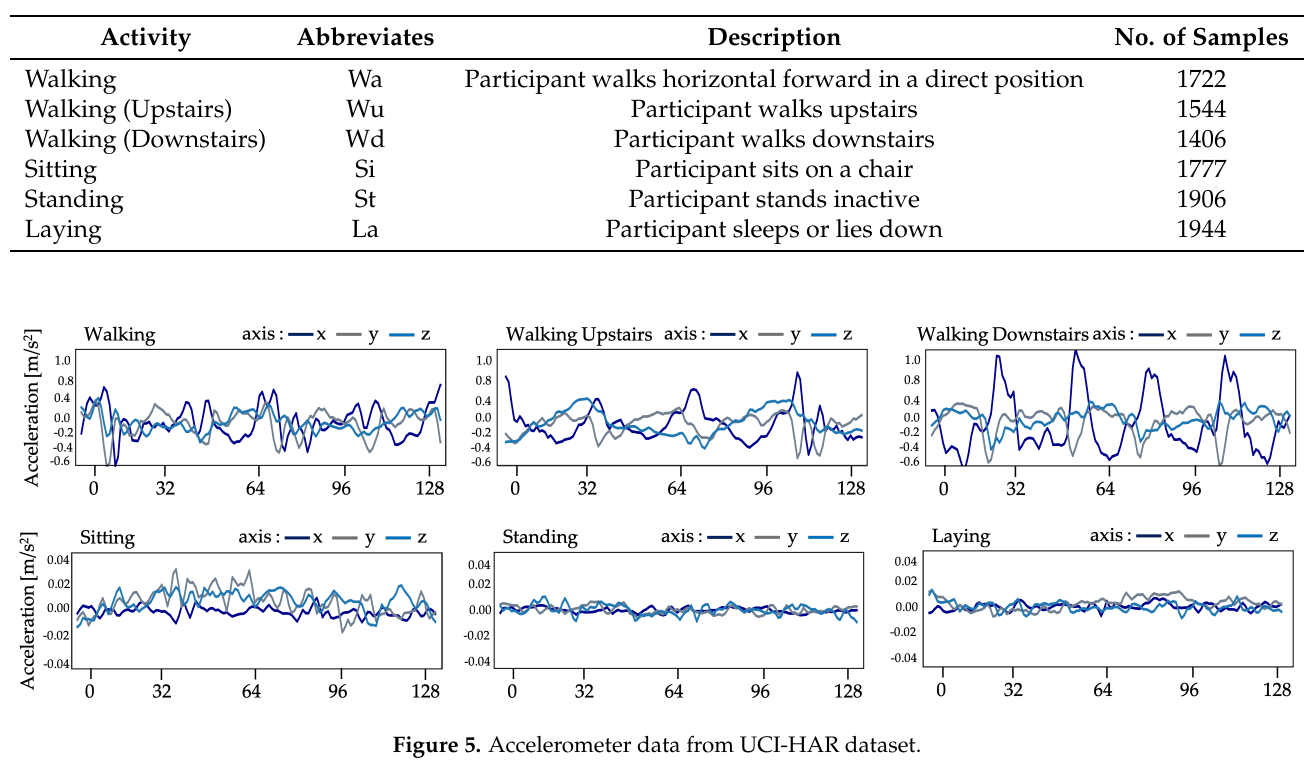
Table 1. Description of UCI-HAR dataset.